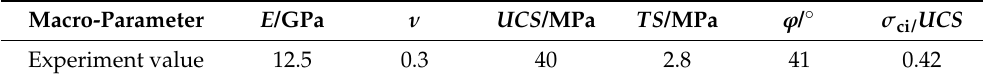
Table 5. Macroscopic mechanical parameters of Transjuane Sandstone